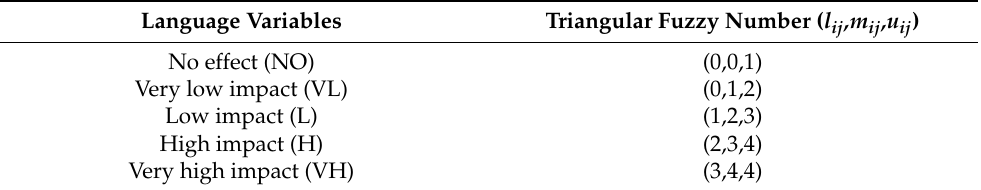
Table 3. Semantic transformation